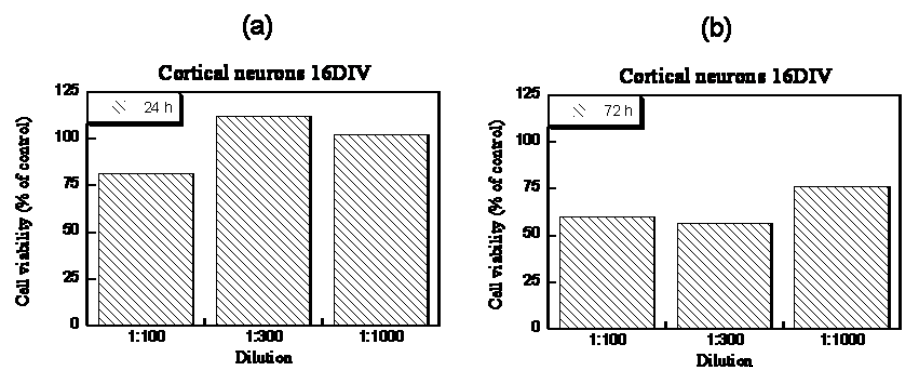
Figure 5. Cell viabilities of 16-day “in vitro” cultured rat primary neuronal cells after incubating for ( a ) 24 and ( b ) 72 h at three concentrations of nanoparticles (1%, 0.3%, and 0.1%). (Reprinted with permission from reference [110]. Copyright 2010 Wiley).